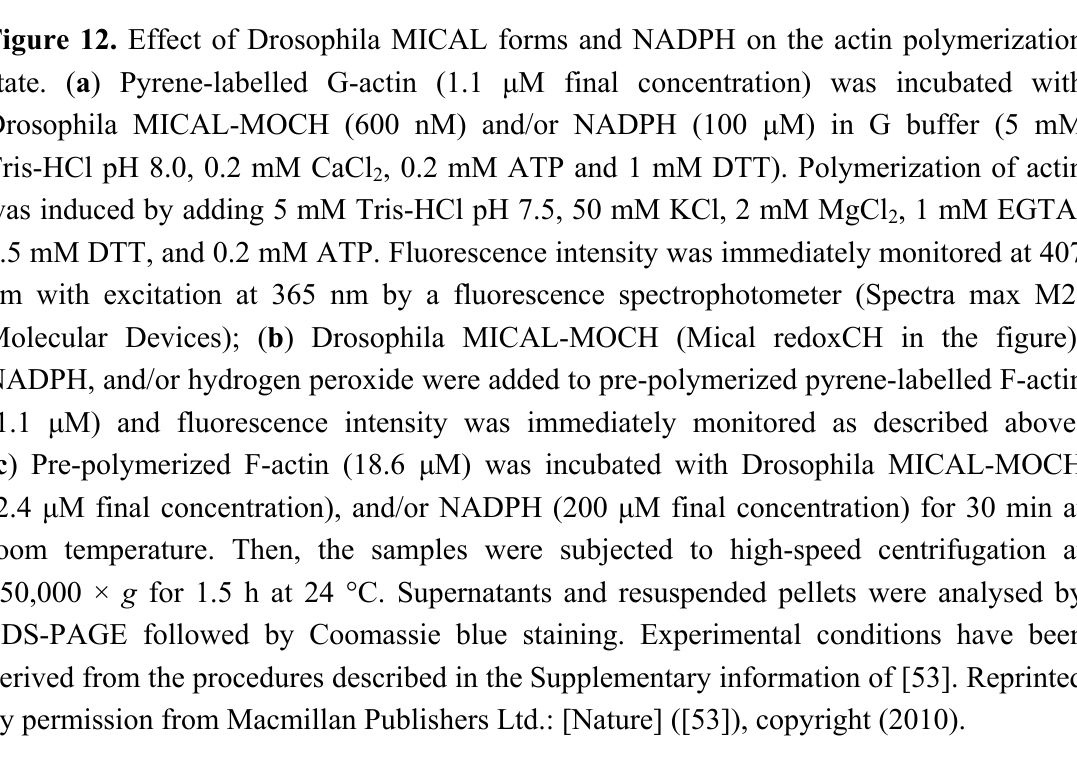
Figure 12. Effect of Drosophila MICAL forms and NADPH on the actin polymerization state. ( a ) Pyrene-labelled G-actin (1.1 μ M final concentration) was incubated